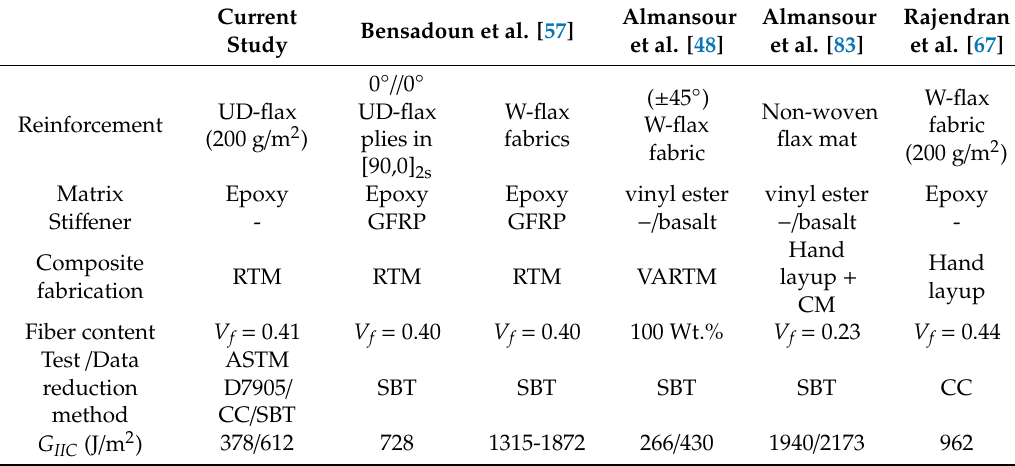
Table 4. Mode II interlaminar fracture toughness tests and values for